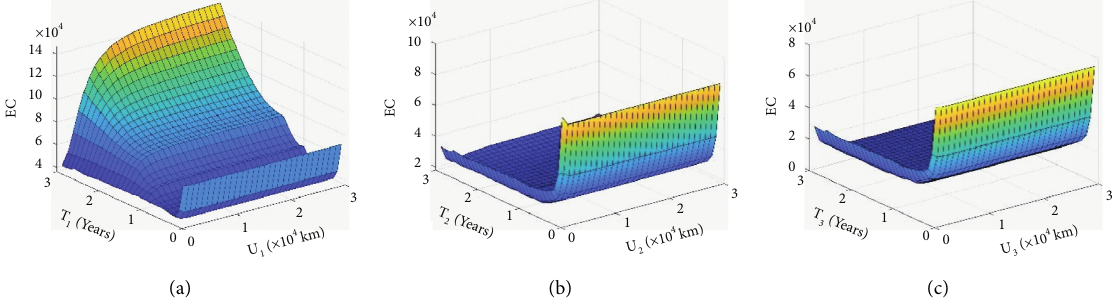
Figure 9: Variation trend of cost during the warranty period of each